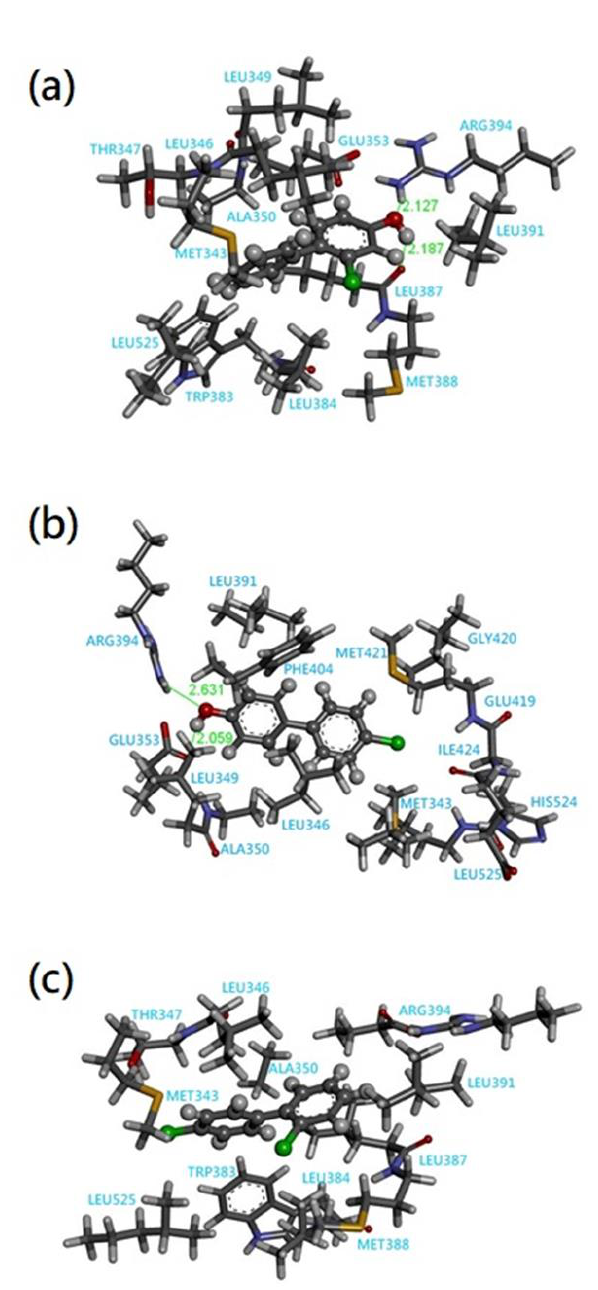
Figure 2. The quantum chemical cluster models for the ERα receptor (PDB 3ERT) with PCB s: (a) 2-Chloro-4-biphenylol, (b) 4-Chloro-4'-biphenylol, and (c) 2,4'-Dichlorobiphenyl. Figure 3a shows 4-Chloro-3-methylphenol ( − 22.19 kcal/mol), whose hydroxyl groups form hydrogen bonds with Glu353 and Arg394 with bond distances of 1.968 Å and 2.183 Å . Figure 3b shows 4-Phenethylphenol ( − 10.19 kcal/mol), whose hydroxyl